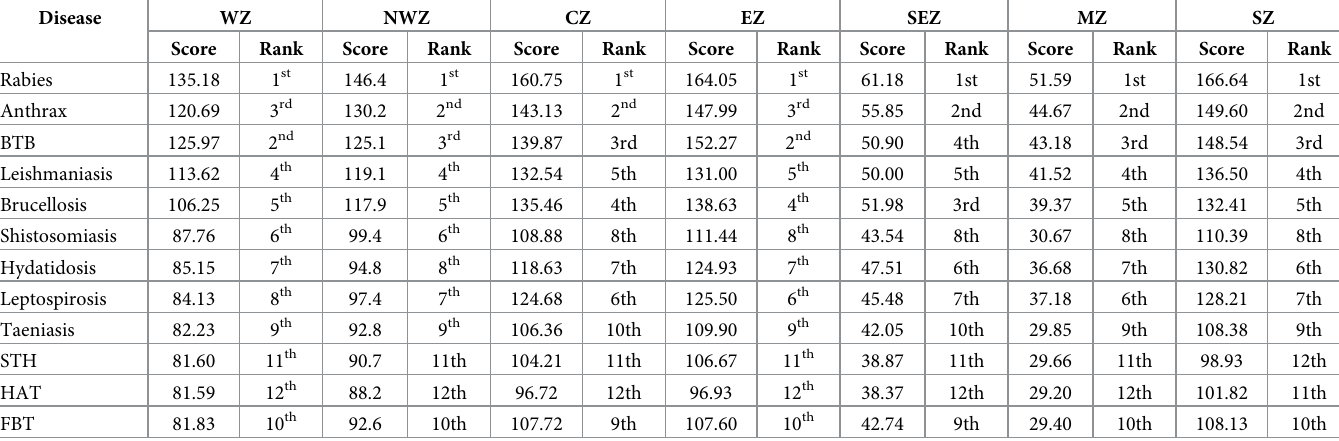
Table 6. Zonal prioritization of neglected tropical zoonotic disease by experts.